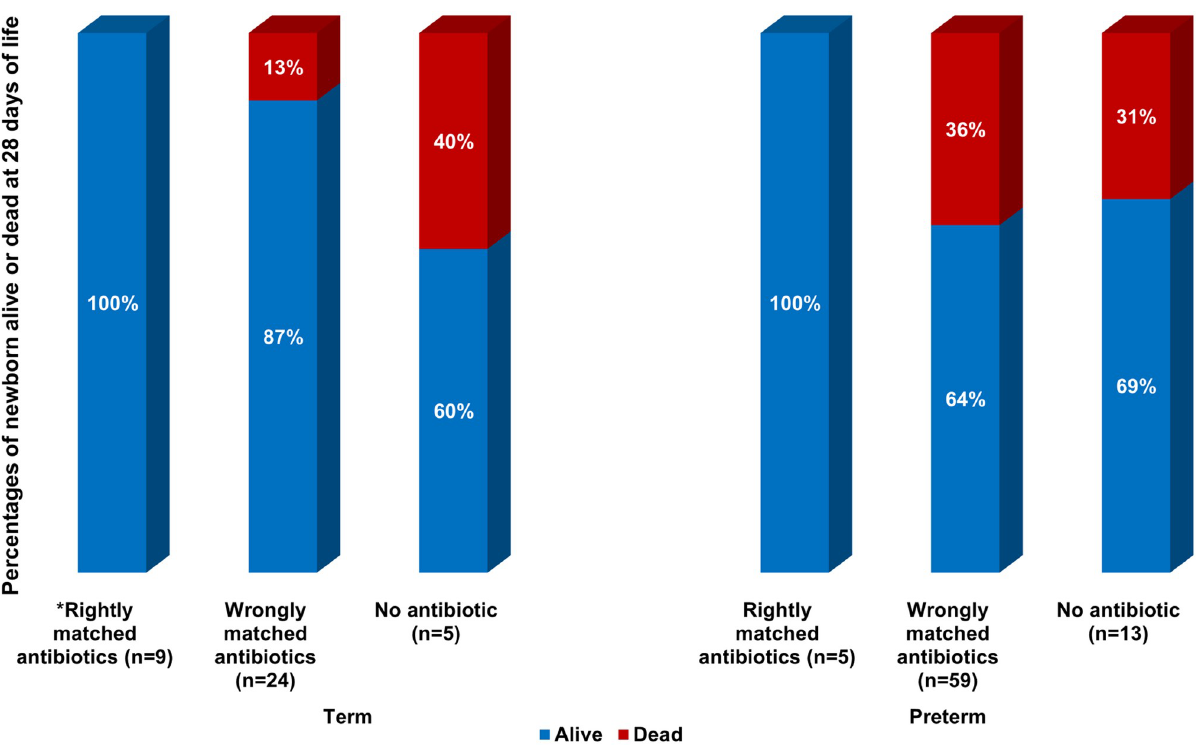
Fig 10. Newborn mortality at 28 days among term and preterm newborns by antibiotic choice (rightly matched, wrongly matched, no antibiotics). There were no deaths at 28 days among newborns who received antibiotics that were effective against their infections. Among newborns who received antibiotics to which their infections were resistant, the mortality rate was 36% (n = 21/58) among preterm newborns and 13% (3/24) among term newborns. � Rightly matched antibiotics represent antibiotic combinations for which the phenotypes of identified gram-negative isolates were susceptible. Wrongly matched antibiotics represent antibiotic combinations for which the phenotypes of identified gram-negative isolates were resistant. No antibiotic refers to no evidence or documentation that any antibiotics were received.